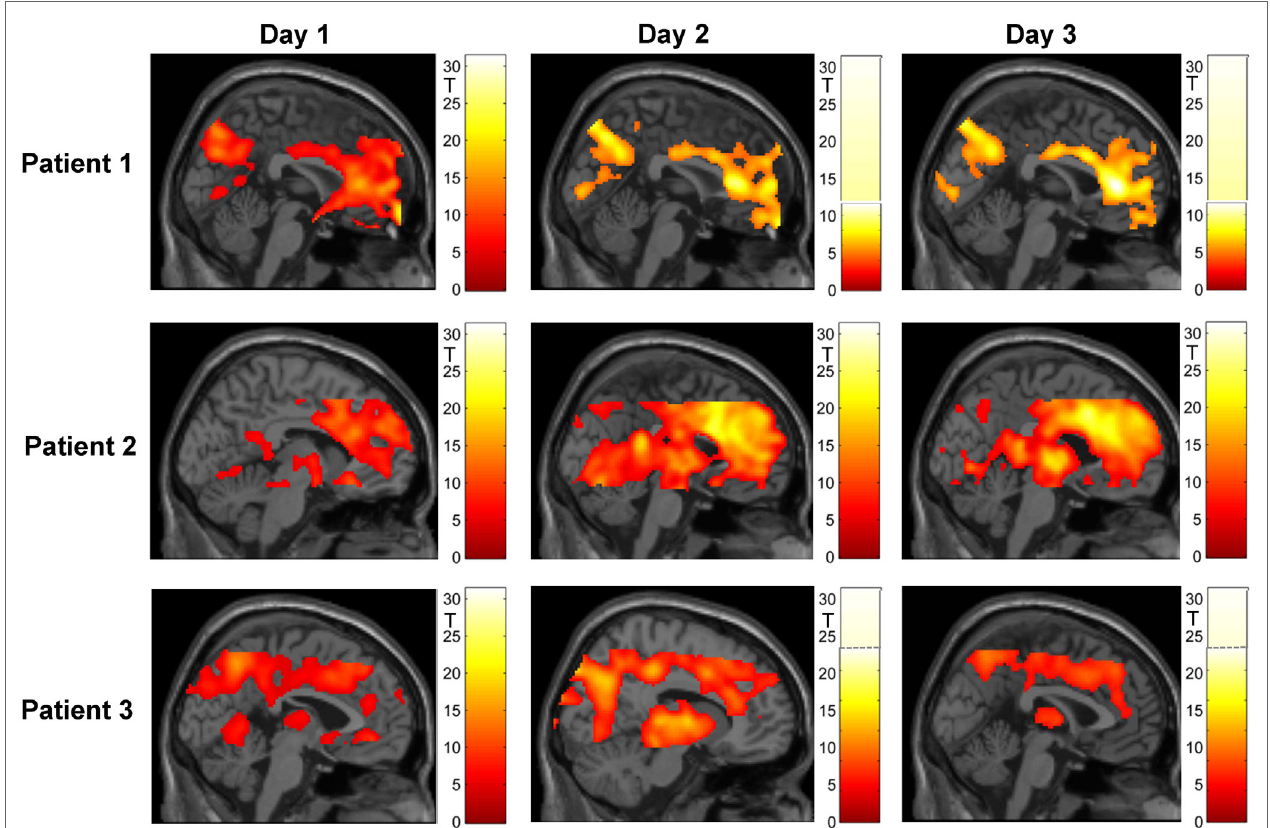
FIGURe 4 | Regulation during the neurofeedback runs as compared to baseline blocks of counting ( p < 0.05, FWe corrected) . The activation patterns did not reveal a clear increase in regulation, but the individual clusters appeared more focused on the ACC over the 3 days of neurofeedback training in patients 2 and 3. Please note that absolute T values differ across training days and across patients (adapted color codes). However, the identical thresholds make the cluster sizes directly